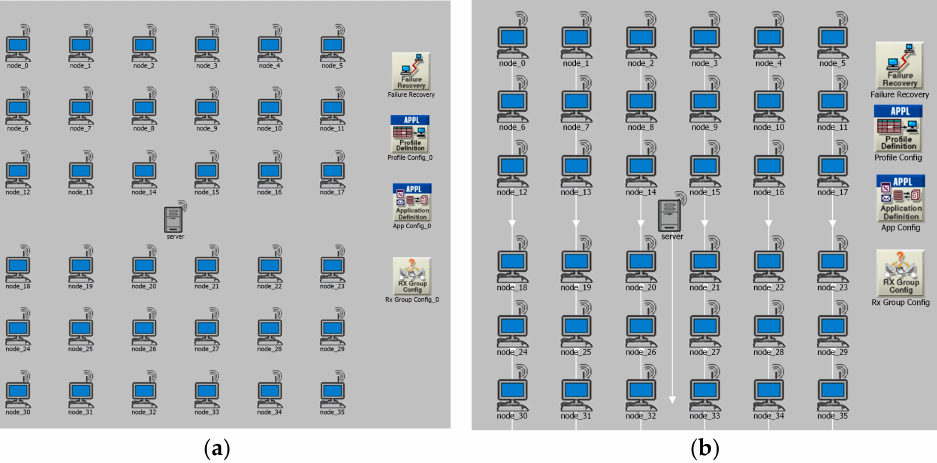
Figure 9. Comparative fixed and mobile node network topology in terms of ( a ) fixed node, ( b ) mo- bile node.